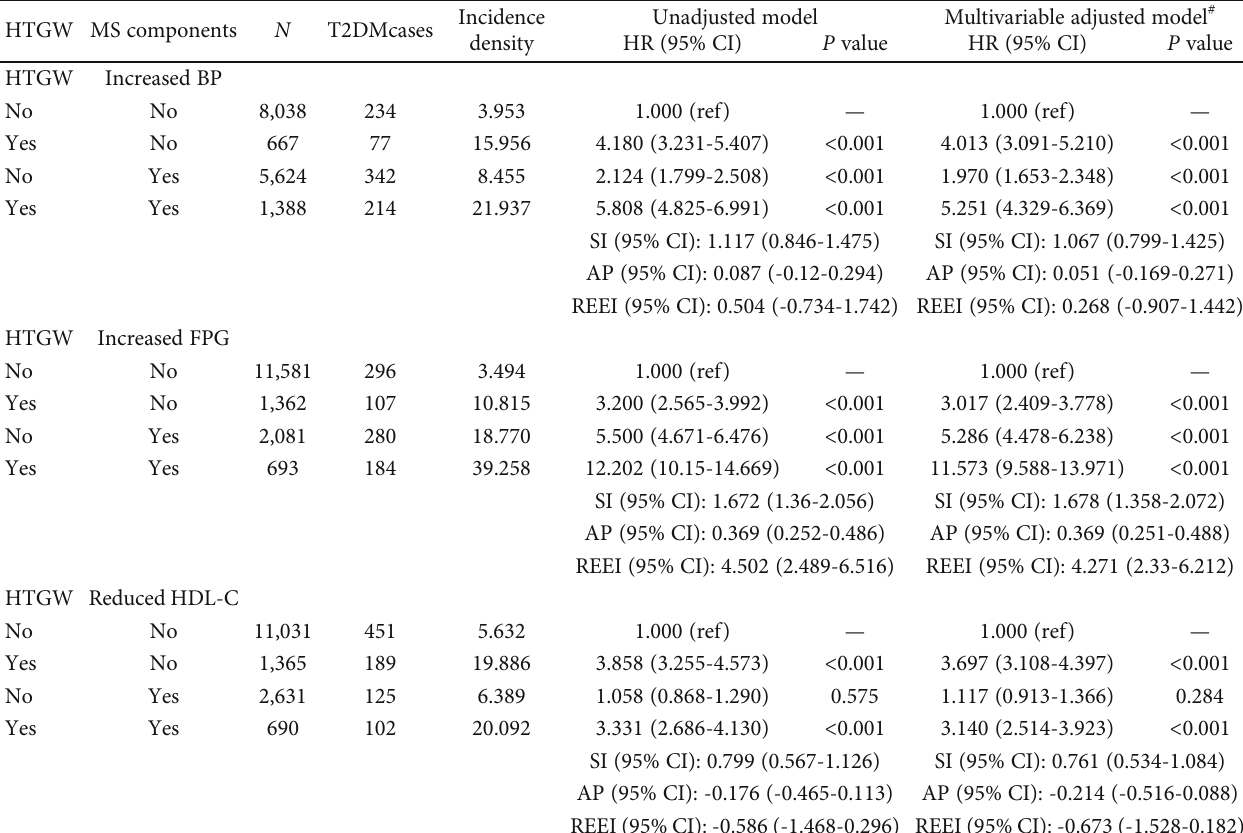
Table 4: Interactions between HTGW and other components of metabolic syndrome on the risk of T2DM. HTGW MS